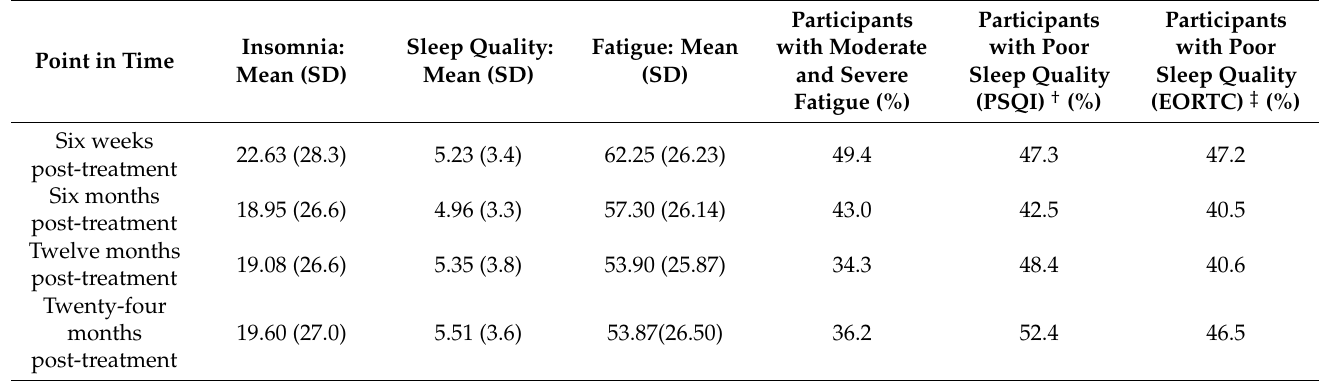
Table A2. Means and standard deviations and percentage prevalence of insomnia, sleep quality, and fatigue at each